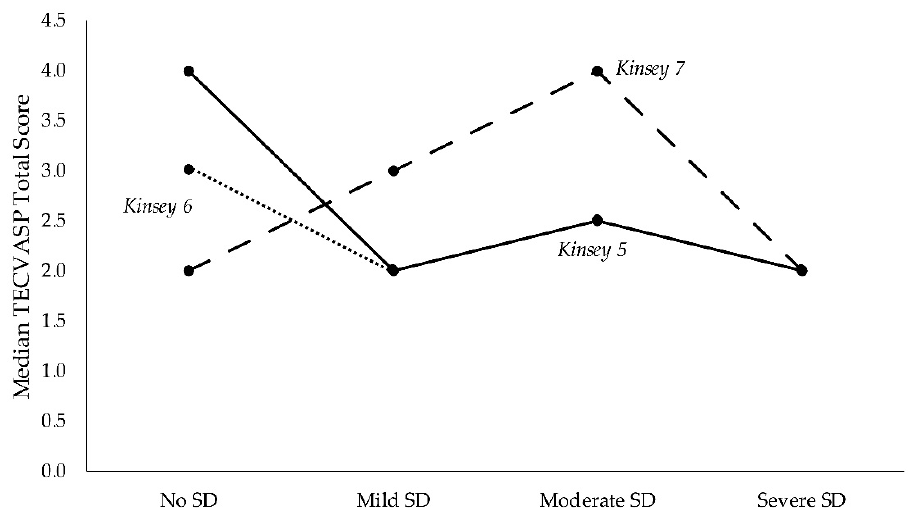
Figure 1. Differences in Kinsey questionnaire items, distinguished by the four SD classes of SALSEX.